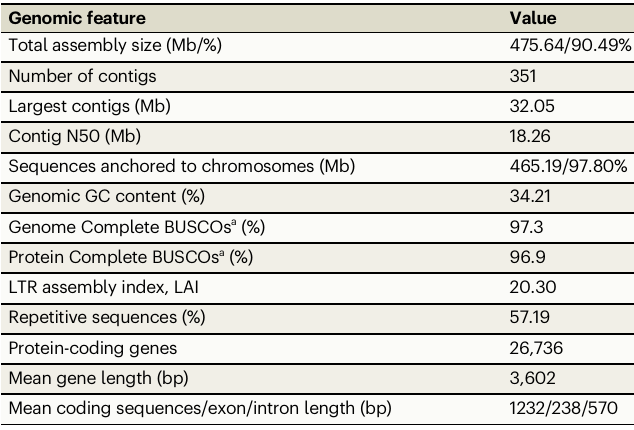
Table 1 | Summary statistics for the rice bean genome assembly Genomic